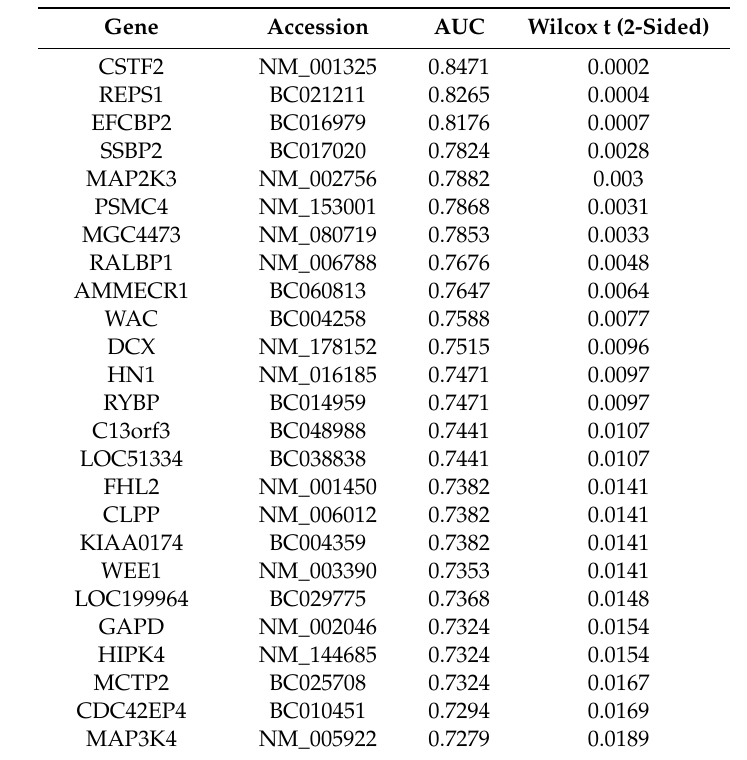
Table 1. Reactivity summary of the 25 most reactive recombinants in high-density recombinant protein